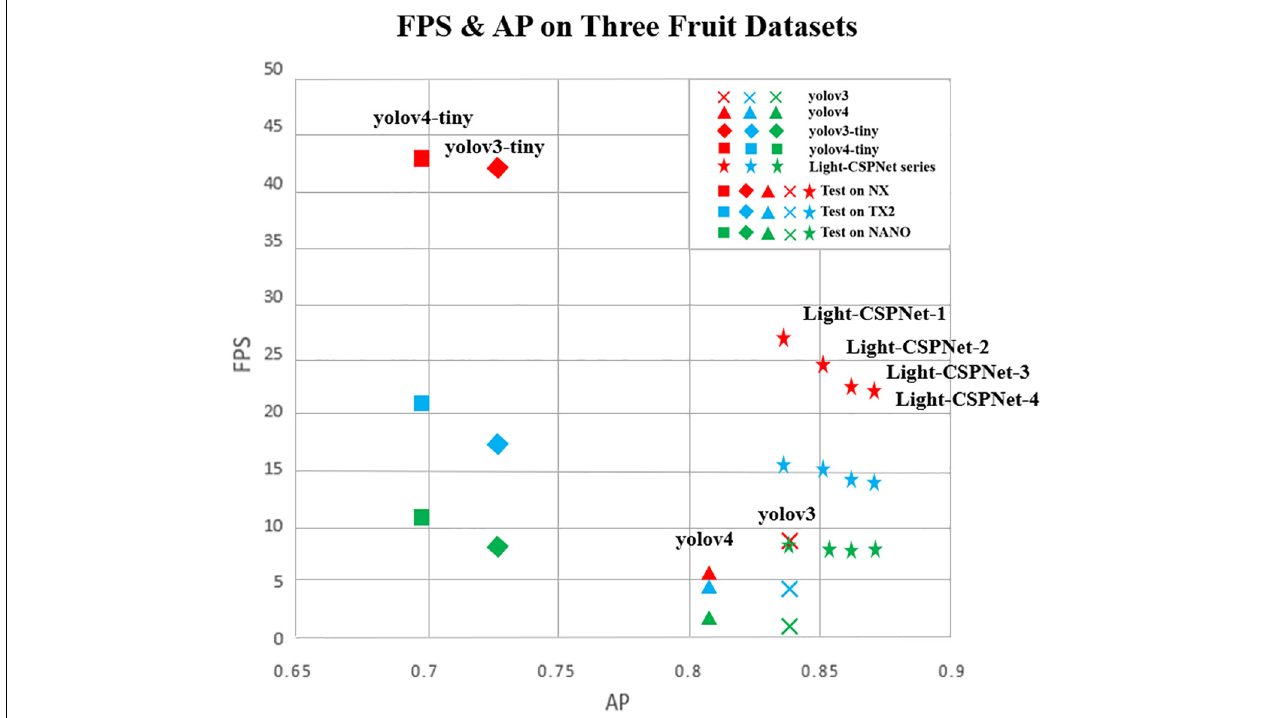
FIGURE 11 | Comparison of the average AP and detection speed performance metrics of different algorithms on the three datasets of orange, tomato, and